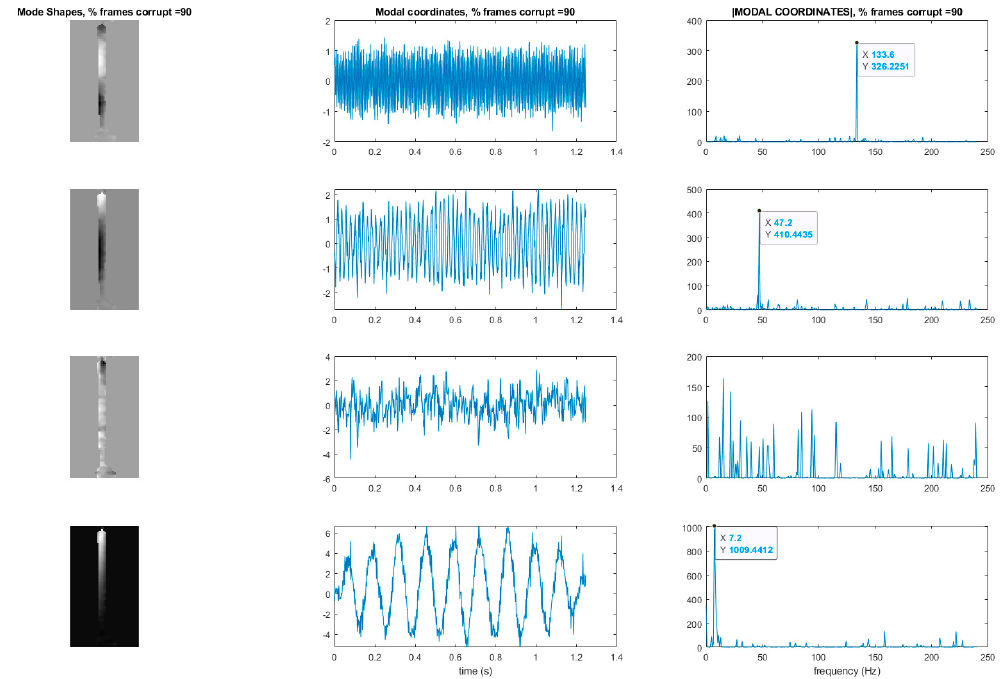
Figure 18. Mode shapes and modal coordinates for the case of L1 reconstruction after the PCA step. Results are shown for the case of 90% of the frames randomly removed. Y-axis of the modal coordinate and the magnitude of the fft(modal coordinate) plots are arbitrarily scaled displacement.